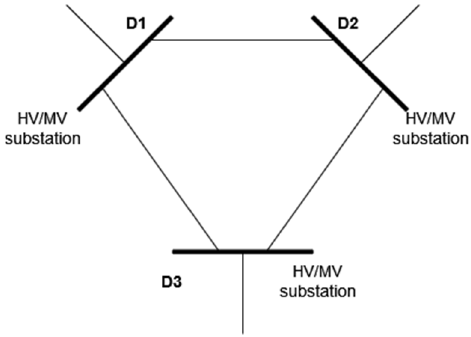
Figure 5. Topology of the OAKA HV/MV substations.